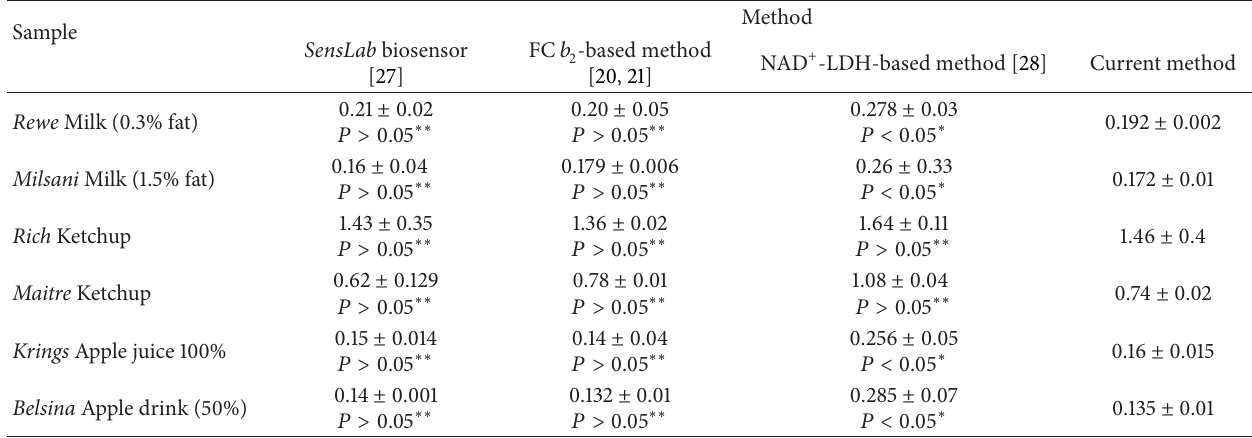
Table 2: Comparison of the results of L-lactate assay (in mM) in food products.